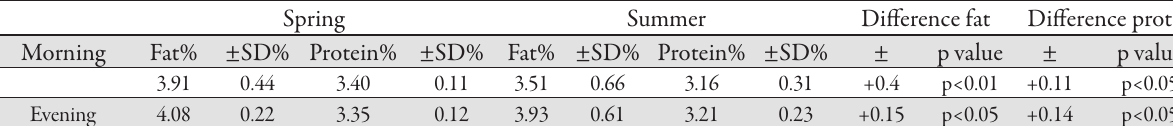
Tab. 2. Seasonal variations of fat and protein content